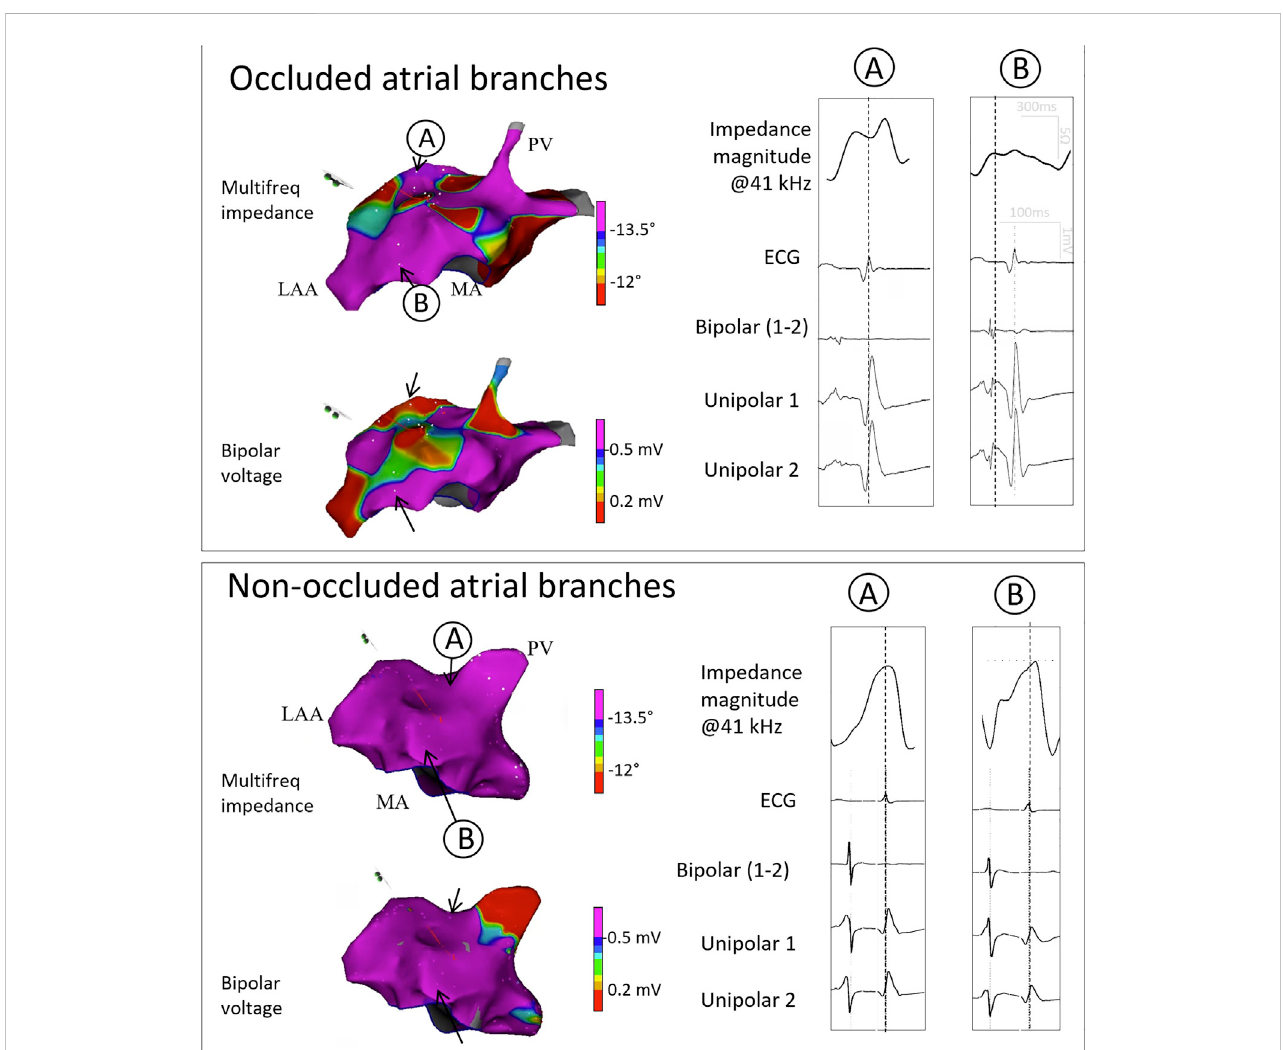
FIGURE 3 Electroanatomicalvoltageand multifequency mapsand corresponding signals intwo representative pigs. The upperpanel shows theelectroanatomical maps and the corresponding multifrequency impedance, ECG, local bipolar and unipolar signals in two selected sites (A,B) in a pig with acute transcatheter occlusion of the atrial coronary artery branches arising from the proximal segment of the left circum fl ex coronary artery. The lower panel shows the electroanatomical maps and the corresponding signals in two selected sites (A,B) in a control pig non-submitted to atrial coronary branch occlusion. LAA: Left atrial appendage; MA: Mitral annulus; PV: Pulmonary